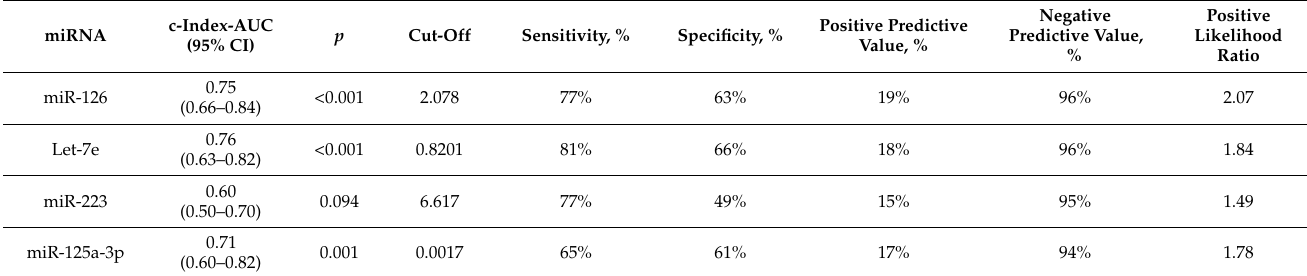
Table 2. Statistical estimates for prediction of all-cause mortality by miR-126, Let-7, miR-223 and miR-125a-3p. miRNA